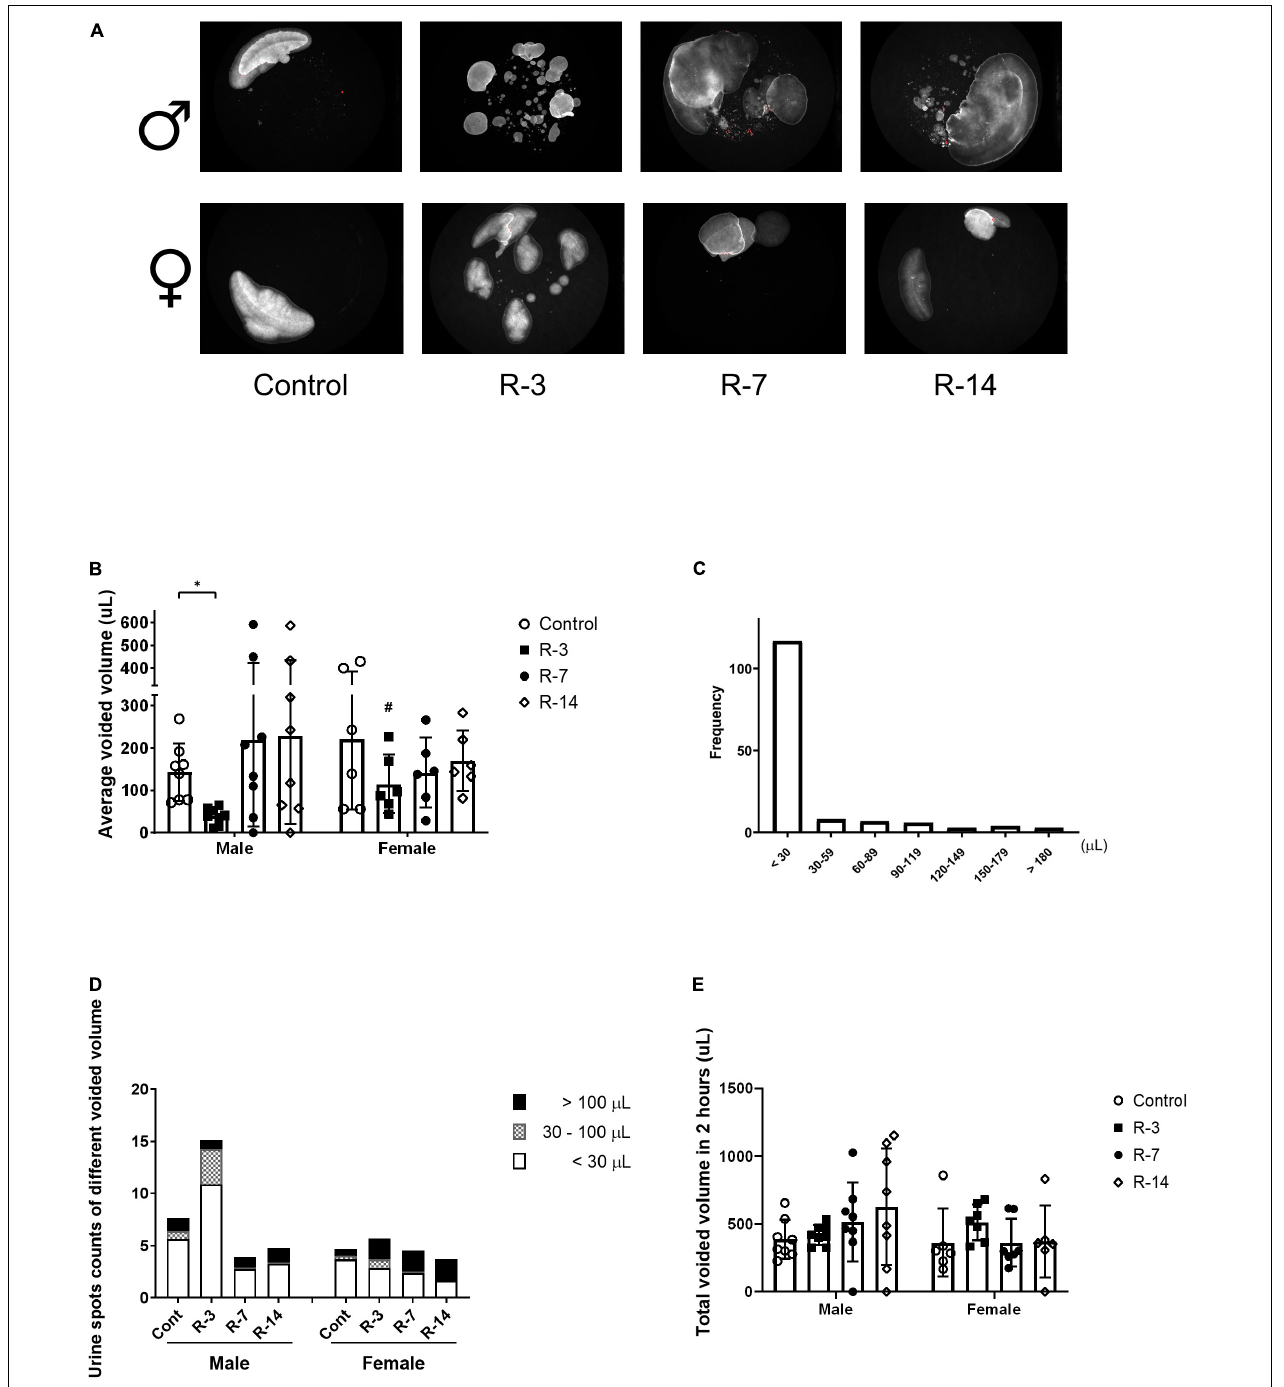
FIGURE 2 | Voiding function changes after release of 24 h total bladder outlet obstruction monitored by voiding spot assay. (A) A representative 2 h voiding spot measure ( n = 8 in each group in the male mice and n = 6 in each group in the female mice). (B) The average voided volume was significantly decreased in the male mice at 3 days post release and returned at 7 and 14 days to the control levels. The average voided volume in the male R-3 group was smaller than that in the female R-3 group. (C) The urine spot distribution by single voided volume in the control mice, of which urine volume less than 30 µ l consisted of the majority. (D) The urine spots count as in less than 30 µ l, between 30 and 100 µ l, larger than 100 µ l were drawn in the chart. The male mice at 3 days post release showed higher counts than the control, which was mainly due to the increase of small volume voids. The female mice showed no changes. (E) The total spot area, represented the total voiding volume in the 2 h recording, showed no changes in both genders during the observation period. ∗ P < 0.05. # P < 0.05 compared between genders with the corresponding